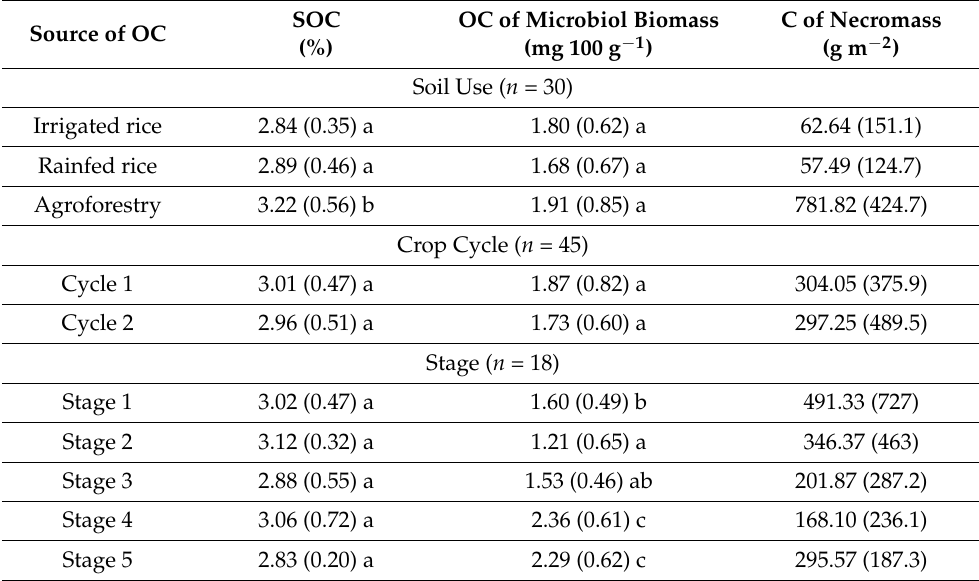
Table 3. Soil organic carbon (SOC), organic carbon (OC) of microbial biomass and carbon of necromass with LSD comparisons at 95% confidence